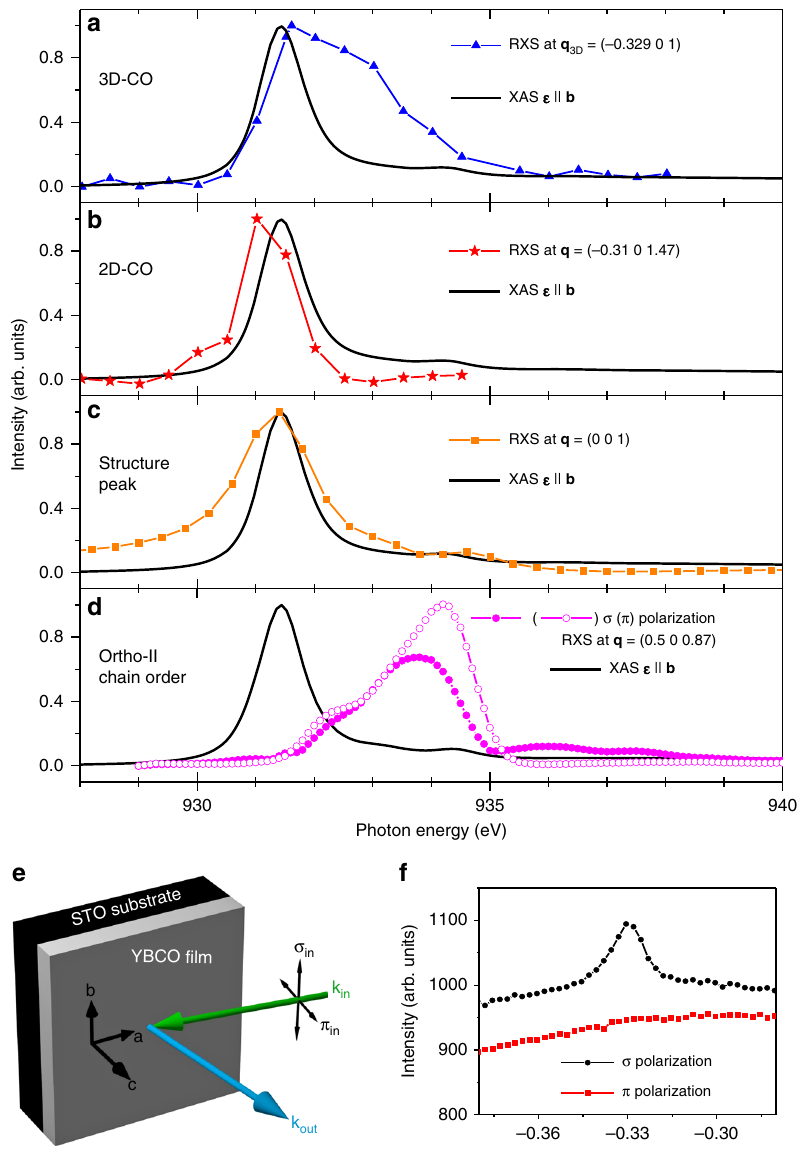
Fig. 3 Photon energy and polarization dependence. a – d Comparison of various energy dependent scattering intensities across the Cu L 3 edge. The data in a – c were measured on a 50 nm YBCO thin fi lm grown on SrTiO 3 (no chain order), whereas the data in d were collected from a single crystal of ortho-II ordered YB 2 Cu 3 O 6.55 . e Scattering geometry used to study the 3D-CO re fl ection at q 3D . f Polarization dependence of the 3D-CO re fl ection as measured in e , and with photon energy tuned to the Cu L 3